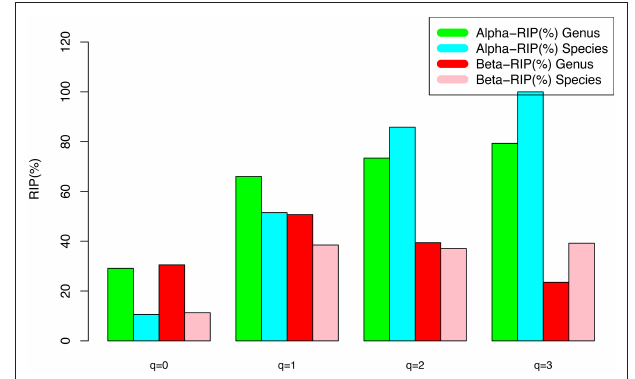
FIGURE 4 | The RIP-profile (RIP- q series) for the semen microbiome diversity (alpha and beta diversity, respectively) at the genus level, for the normal, sub-normal, abnormal, and combined groups,